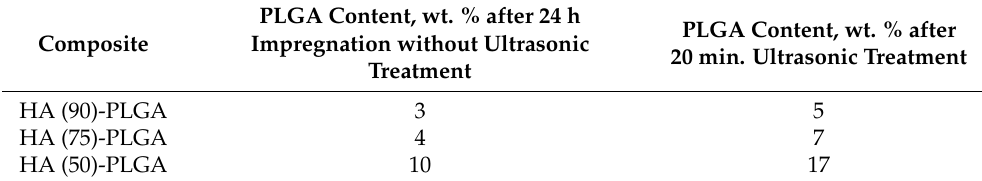
Table 4. The ratio of components in composite HA-PLGA.